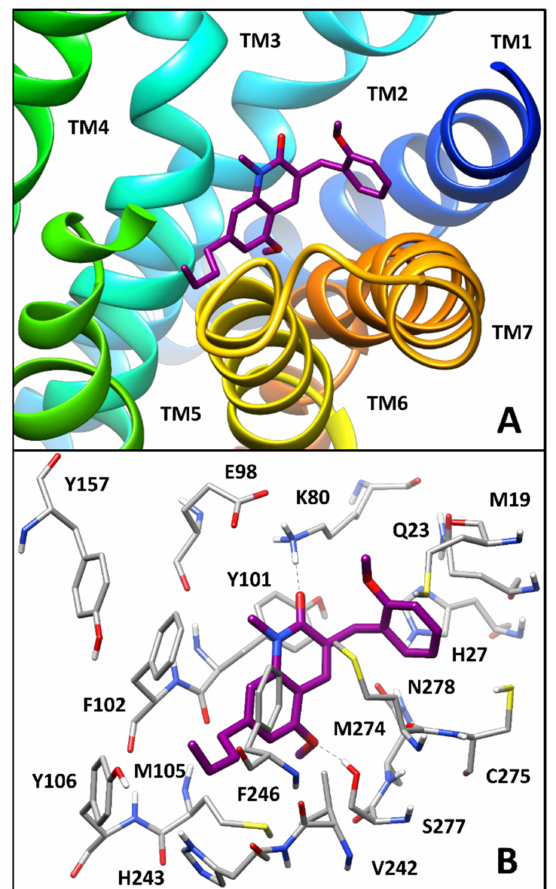
Figure 6. Minimized average structure of compound 2 within the binding site of the h GPR55 model. ( A ) The ligand (purple) and the different transmembrane domains of the receptor are shown; ( B ) the protein residues (gray) surrounding the ligand within the receptor binding site are shown, with ligand–protein H-bonds highlighted with black dashed